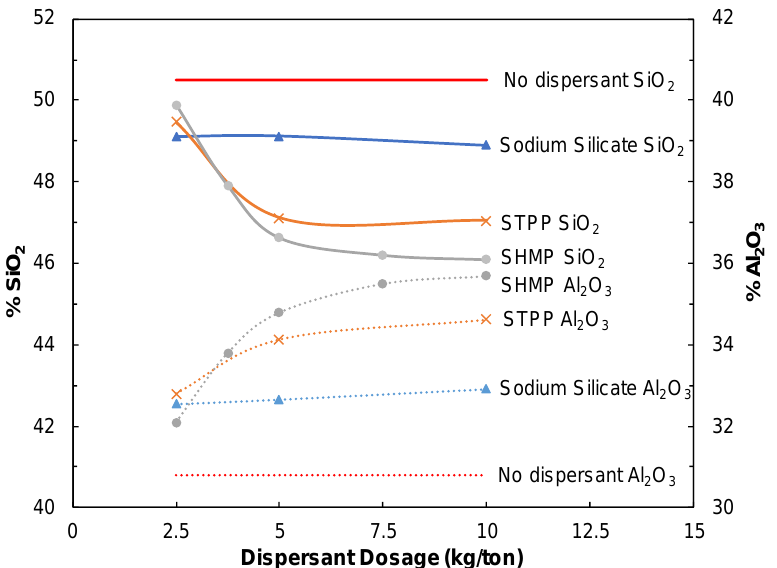
Figure 14. Change in the ratio of material passing to <38 µm size halloysite ore according to disper- sant types and dosages (1000 rpm blunging speed and 35% pulp concentration at 25 °C room tem- perature and natural pH of 3.9).